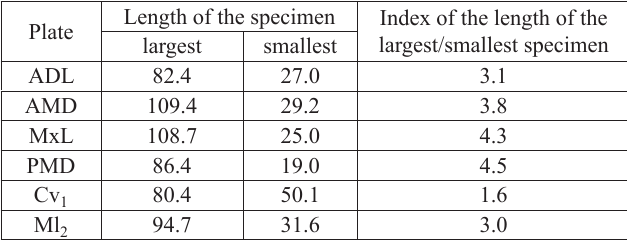
Table 1. Length (in mm) of the smallest and largest specimens of sev- eral plates of Bothriolepis leptocheira jeremejevi . Length of the specimen Index of the length of the Plate largest/smallest specimen